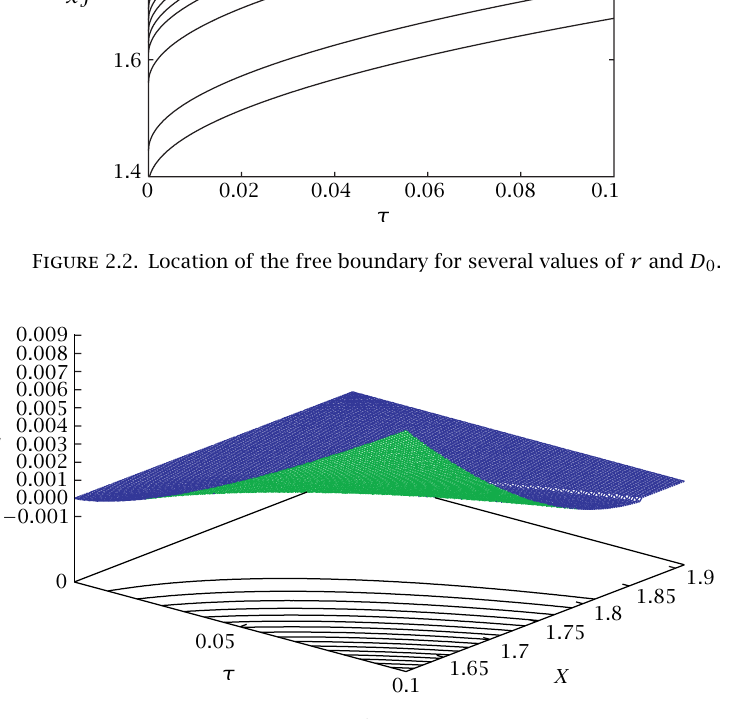
Figure 2.3 . Solution of the price option c(X,τ)